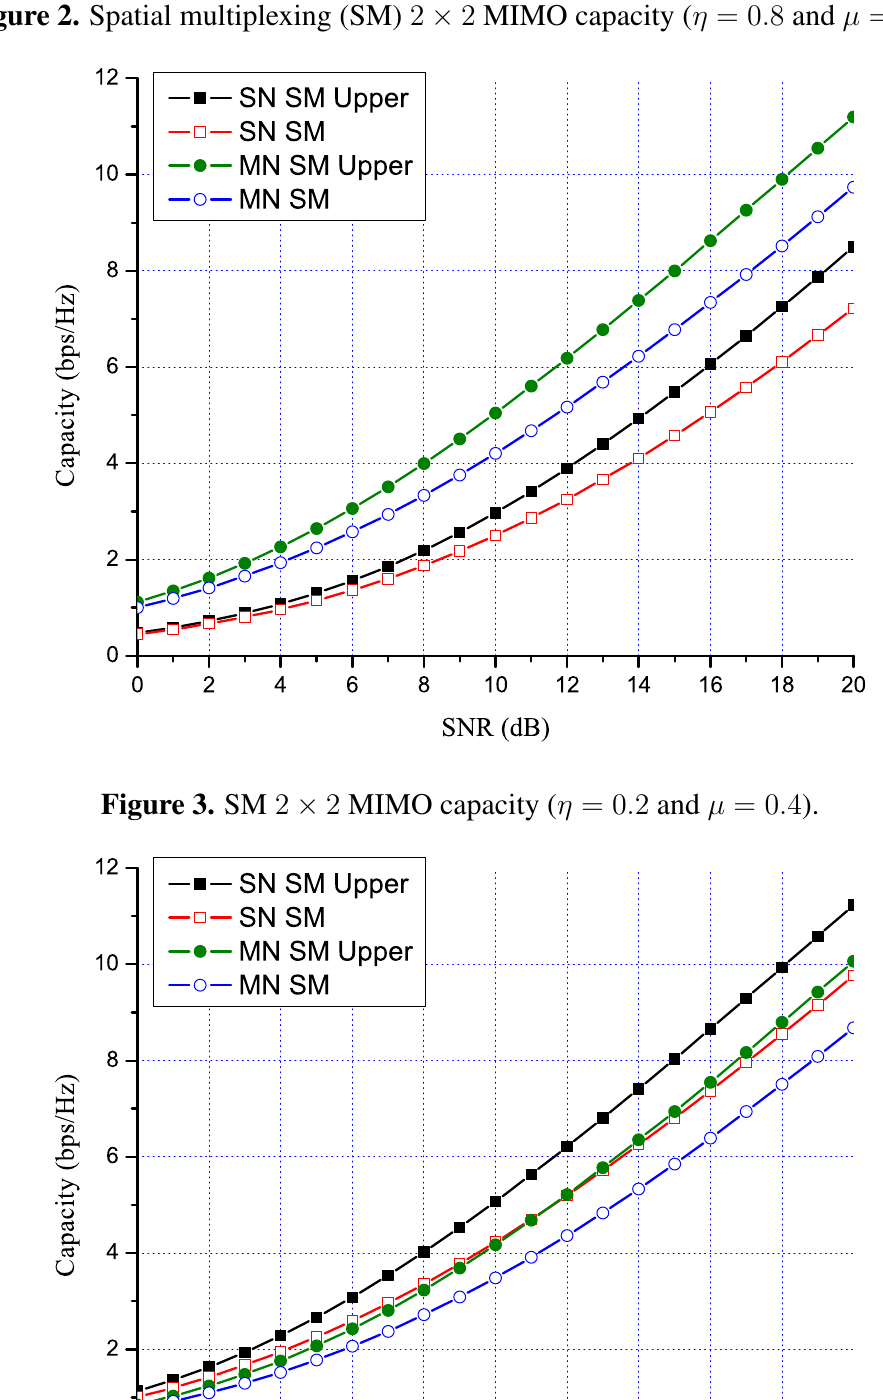
Figure 2. Spatial multiplexing (SM) 2 × 2 MIMO capacity ( η = 0 . 8 and µ = 0 . 9 ).